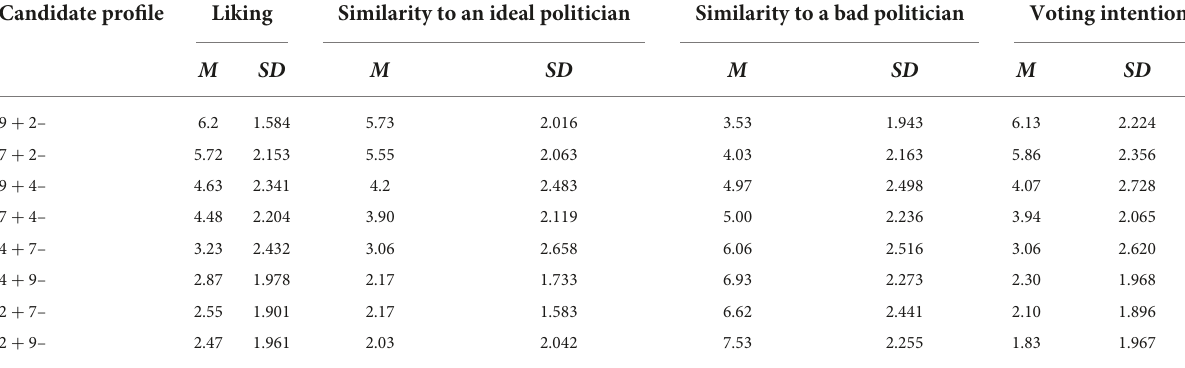
TABLE 3 The means for liking, similarity measures and voting intention of candidates analyzed in the study. Candidate